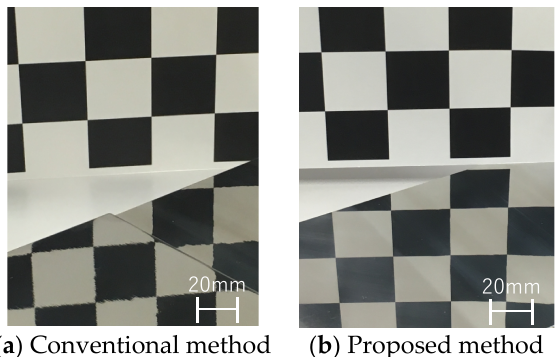
Figure 17. Machined surfaces under the conventional method with a flap wheel ( a ) and the proposed method with the 400SP wheel ( b ).